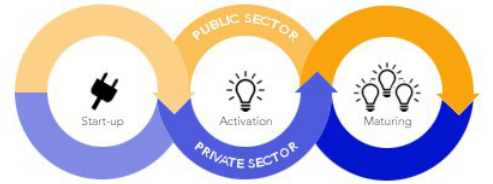
Figure 2. Framework to analyse the innovation district multi- stage development (Authors’ elaboration)